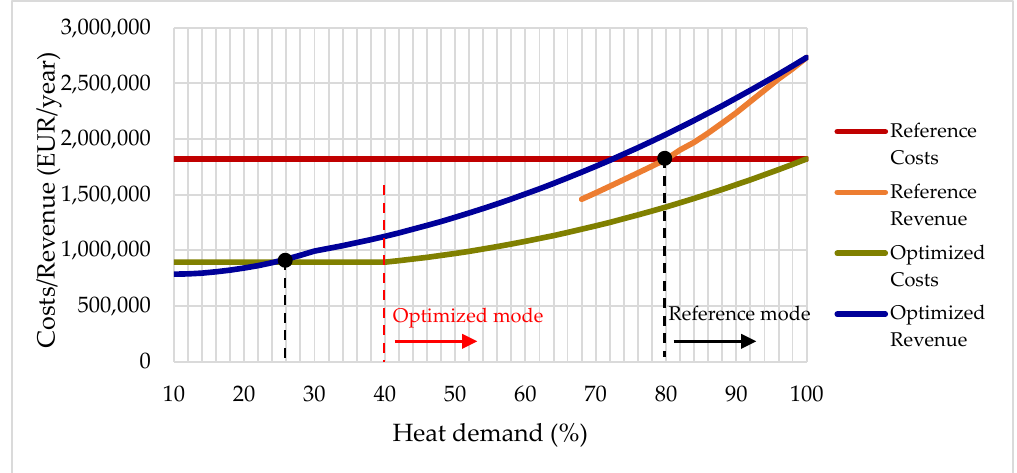
Figure 10. Optimizing the operation of the CHP plant.